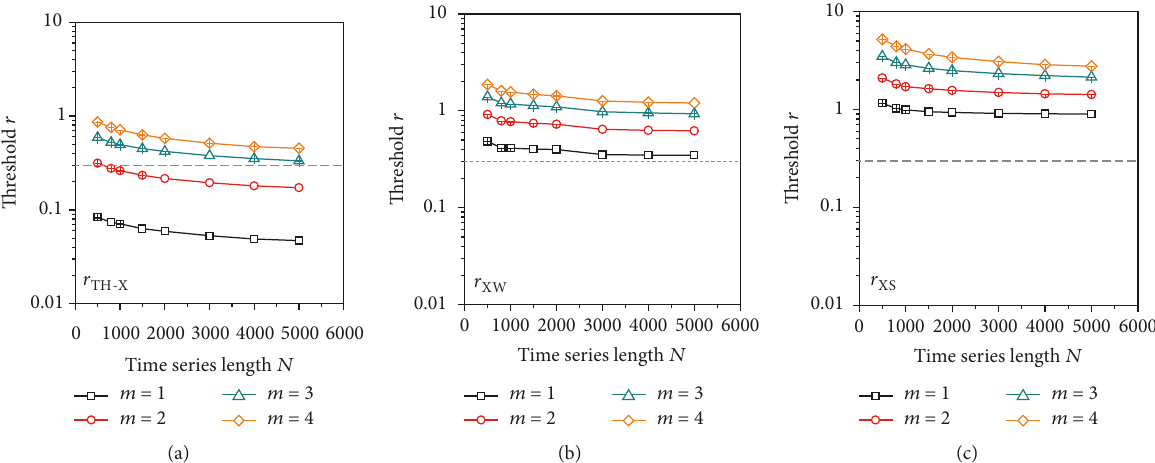
Figure 8: Unreliable estimated probabilities ̂𝑝 𝑚 𝑖 (𝑟) [ % ] in real signals; (a) 𝑟 ∈ {𝑟 XW , 𝑟 and strong criterion is applied. The gray dashed horizontal line marks 10% of the unreliable probability estimates. The left part of each panel shows the results of Wistar and borderline hypertensive rats at baseline and stress; the right part of each panel shows the results of volunteers.